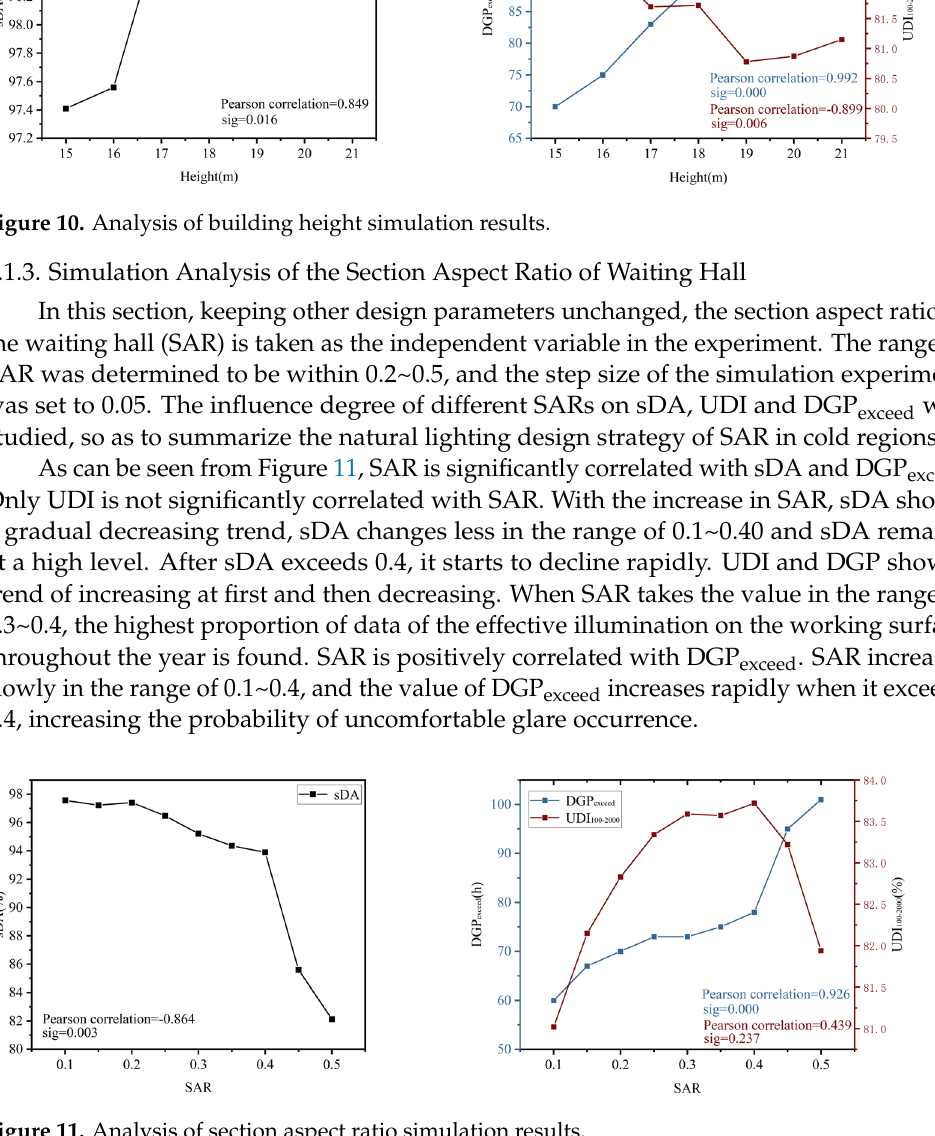
Figure 11. Analysis of section aspect ratio simulation